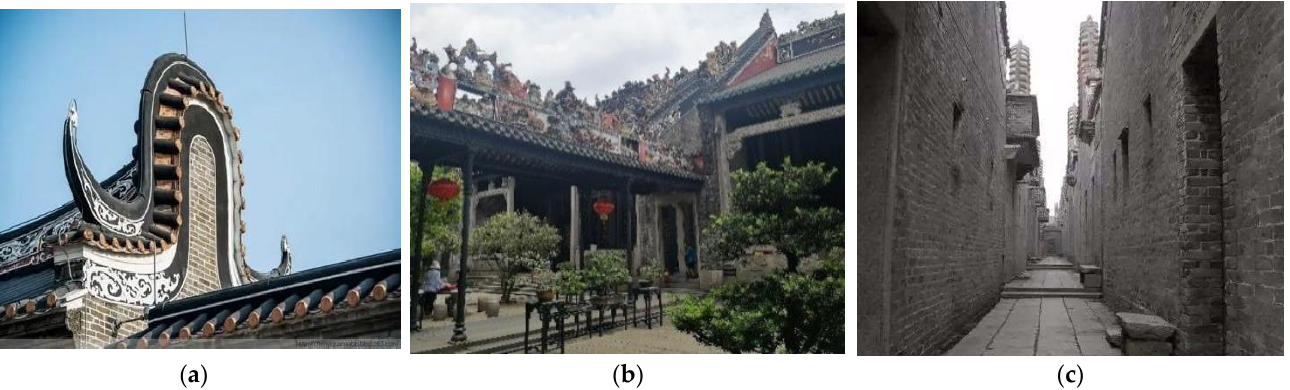
Figure 15. Ventilation structures at Chen Clan Temple. ( a ) The Horsehead Wall. ( b ) The Corridor. ( c ) The High Wall.